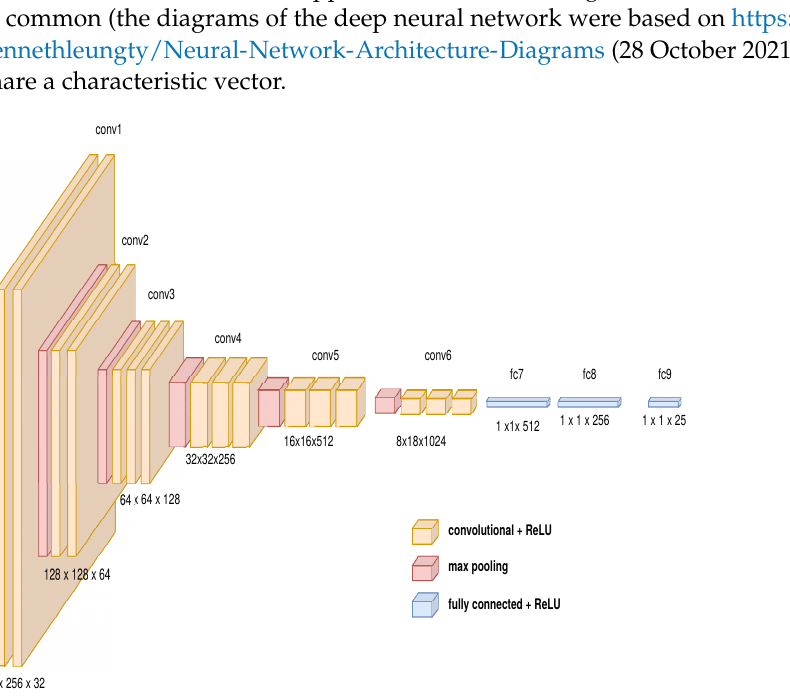
Figure 11. Features of the DCNN model to generate the characteristic